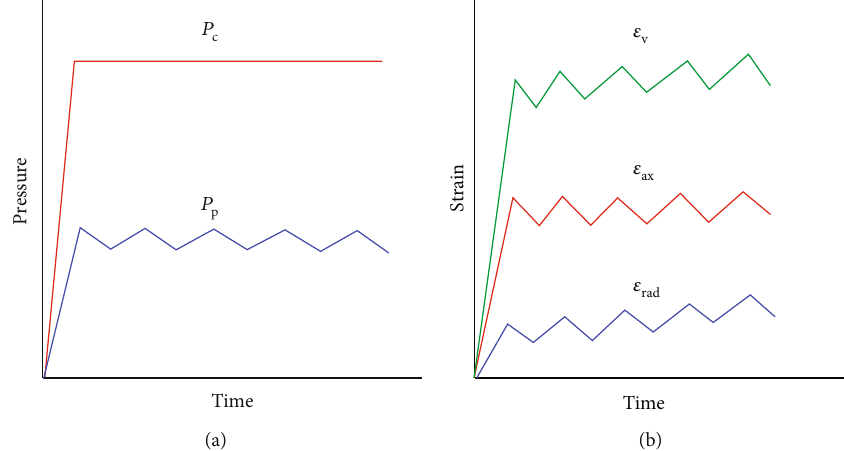
P c ) and pore pressure ( p ) over